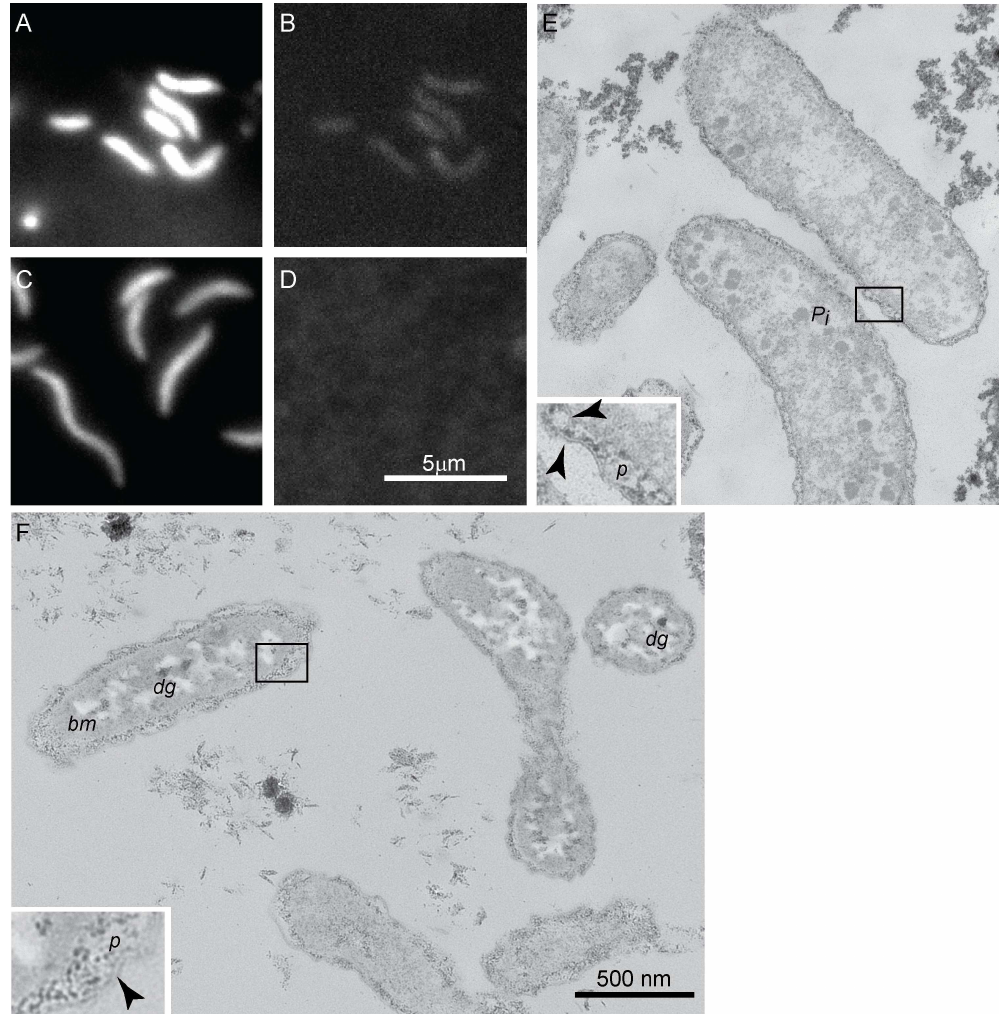
Fig 2. Transmission electron and epifluorescence micrographs of G20 from phosphate-replete and phosphate-limited cultures. (A) Blue fluorescence of DAPI-stained G20 cells not limited by phosphorus. (B) Green fluorescence of DAPI-stained G20 not limited by phosphorus indicatesthe presenceof polyphosphate. (C) Blue fluorescence of elongated, DAPI-stained G20 cells limited by phosphorus. (D) Green fluorescence of DAPI- stainedG20 cell limited by phosphateis not detectabledue to the absenceof polyphosphate granules. Panels (A)- (D) are shown on the same scale. (E) Cells grown at 27˚C in MOLS4 with 200 μ M initial phosphate. (F) Cells grown at 27˚C in MOLS4 with 2 μ M initial phosphate. Panels (E) and (F) are shown at the same scale shown in (F). Insets in (E) and (F) show enlargedareas outlinedby the black rectangles. Black arrows point to the inner and outer membranes, p indicatesthe periplasm, P i marks polyphosphate granules, bm labelsa representative area filled with bright material, dg marks a small dark